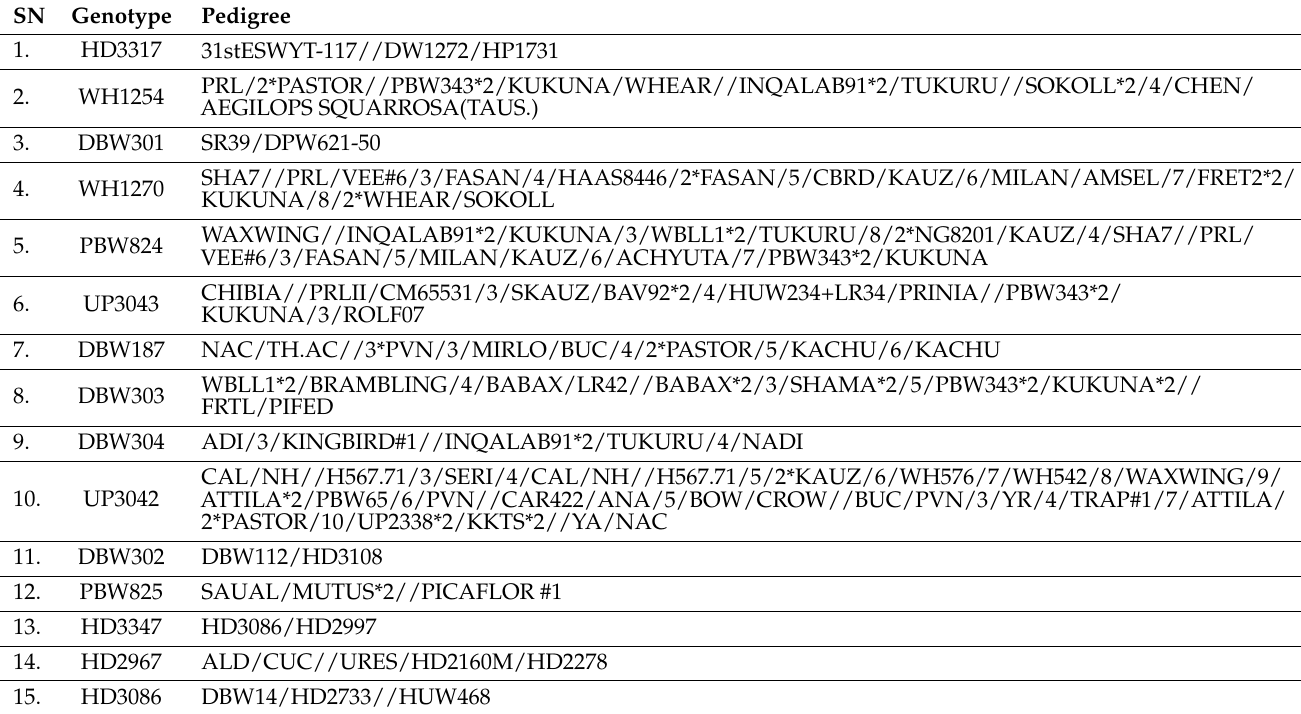
Table 6. Pedigree details of the genotypes used in the study.